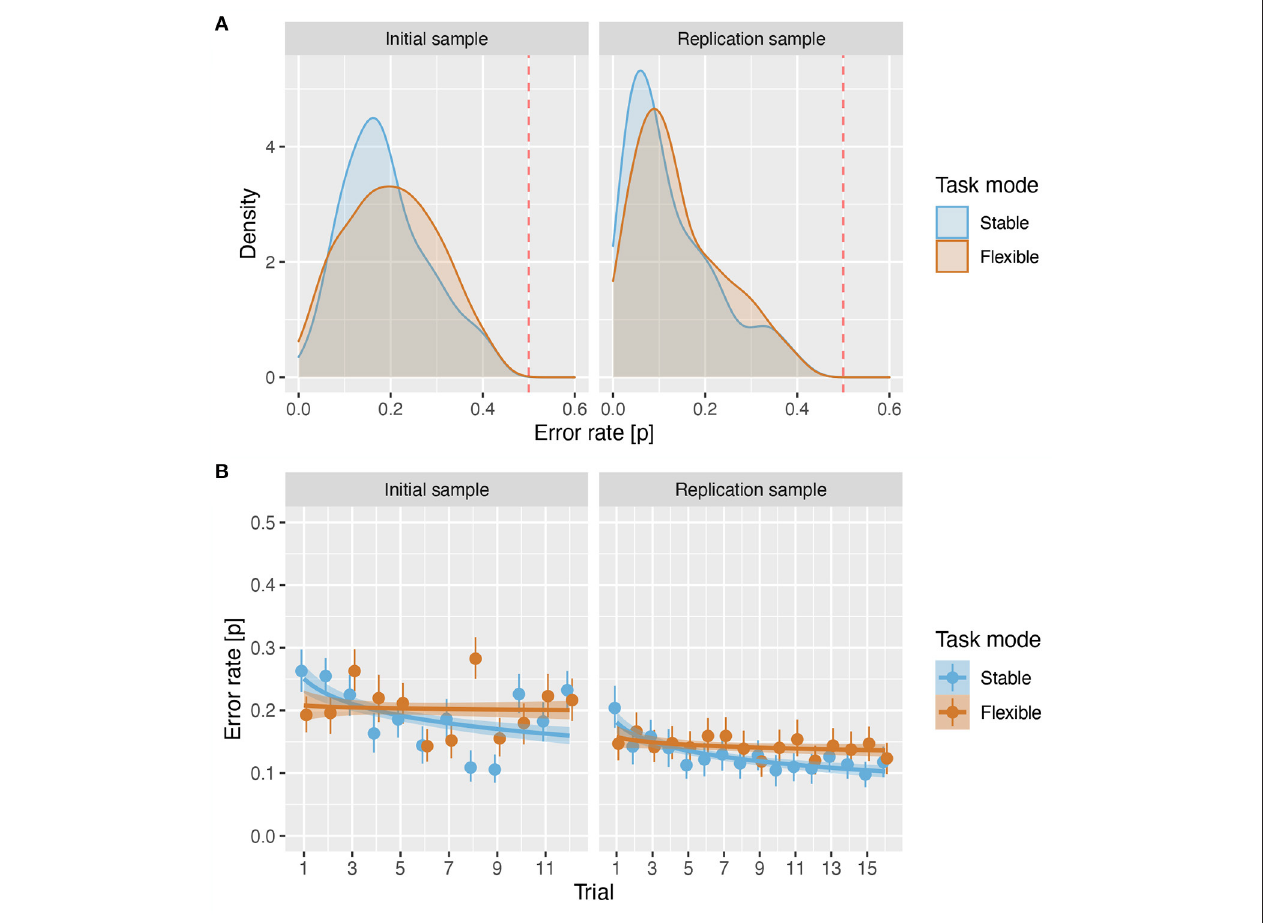
FIGURE 3 | Error rates. (A) Density plot of error rates for both samples in stable and flexible task modes. The red line shows the error rate of 0.5. (B) Proportion of errors across all participants and rule types for each trial number. The circles show the mean error rate and the handles show the 95% confidence intervals. The lines show the predicted values based on a linear regression with trial and mode as predictors, and the shading shows the standard error of the predicted values.